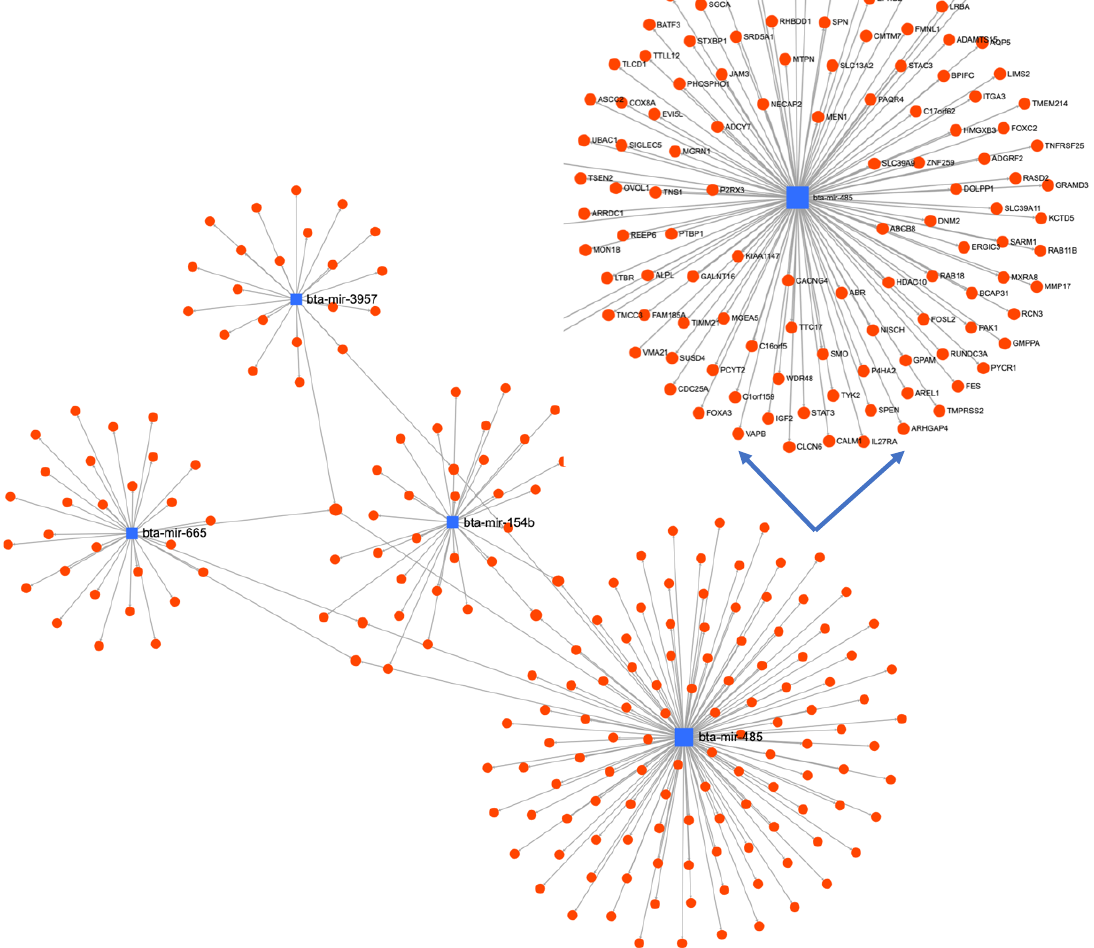
Figure 5. miRNA-mRNA-miRNA interaction network of differentially expressed miRNAs using MirNet online tool.